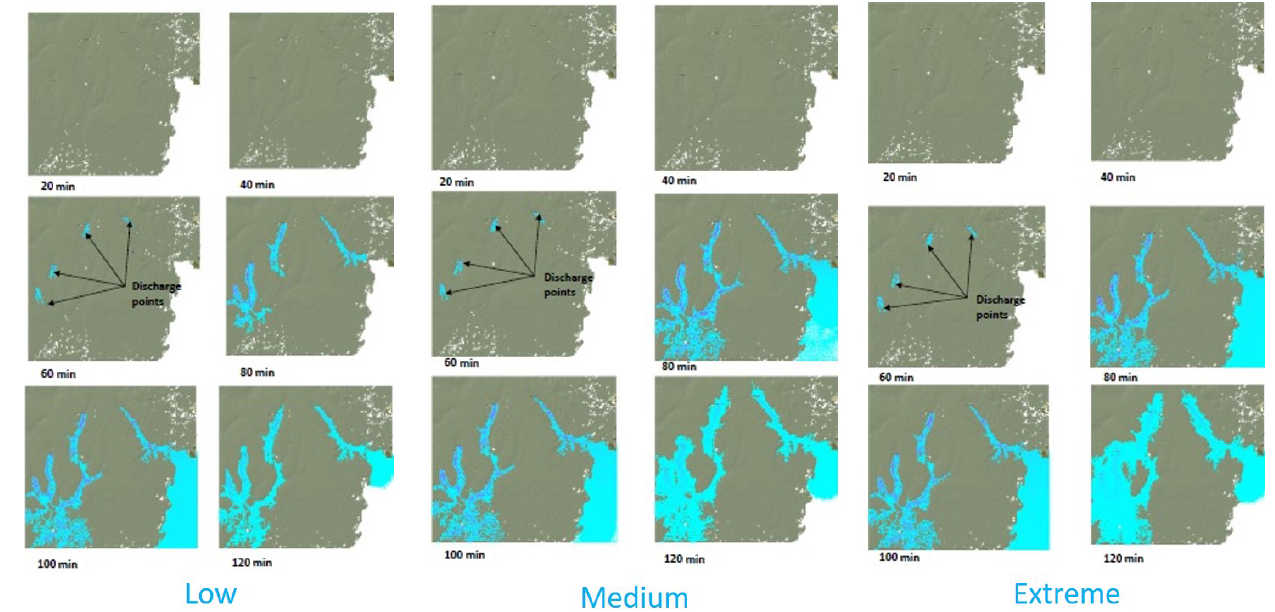
Figure 3. Simulated flow for Lagos